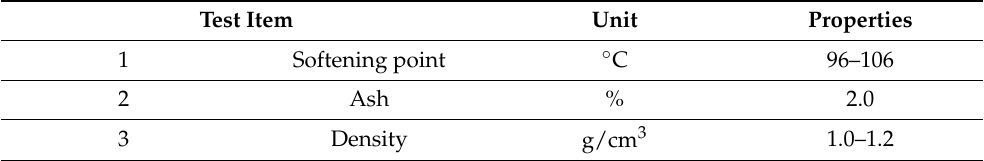
Table 7. Coupling agent properties used in the